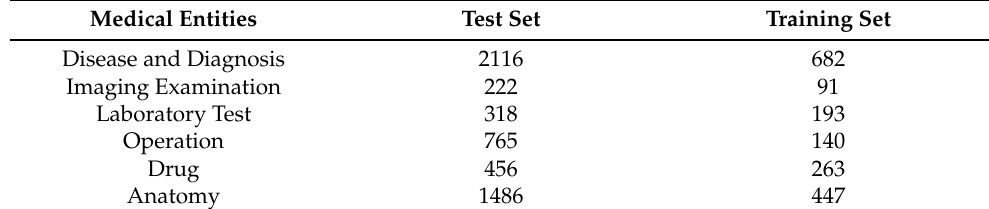
Table 1. Statistics on the number of different types of entities (unit: %).